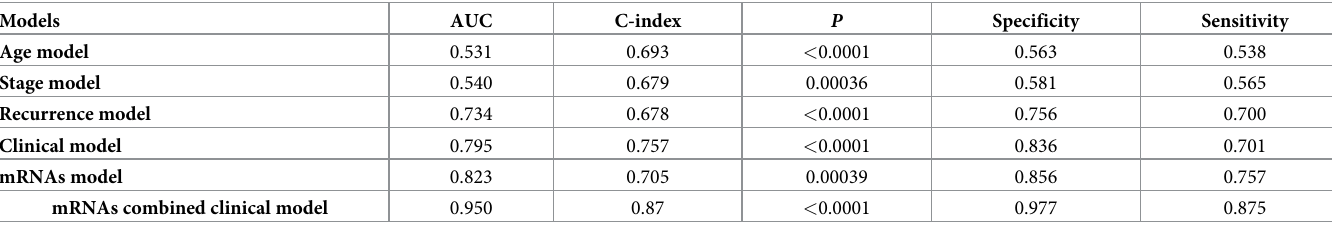
Table 4. Parameter information of each